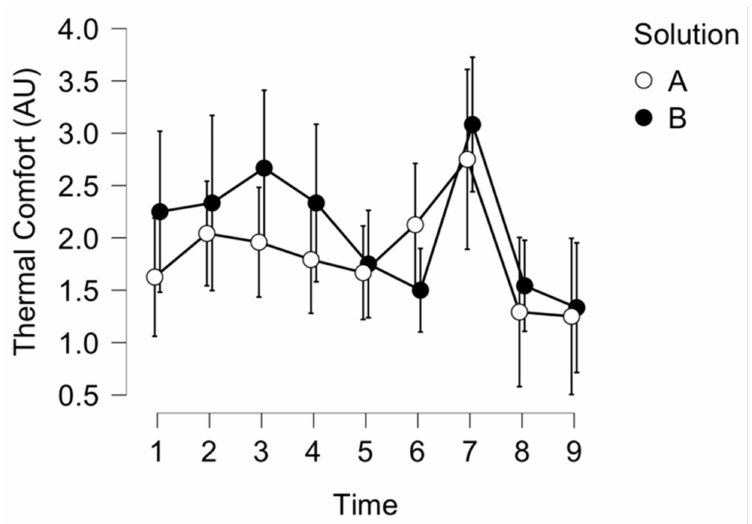
Figure 1. Participant ratings of thermal comfort following swilling solution A and